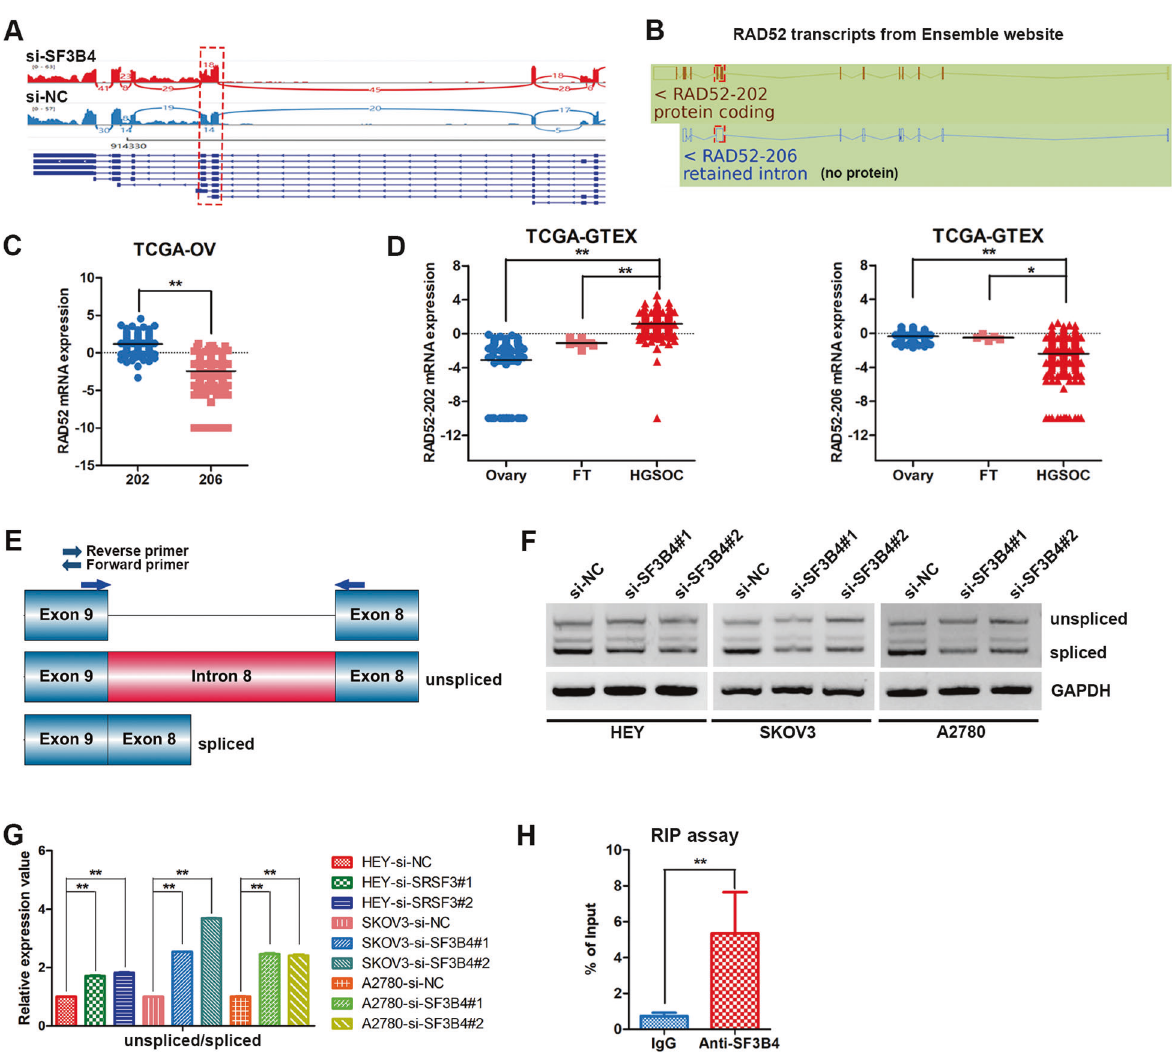
Fig. 5 SF3B4 facilitates ef fi cient splicing of RAD52. A Sashimi plot visualization of RNA-seq reads mapping to RAD52 in HEY cells in response to SF3B4 knockdown. B Schematic diagram showing two splicing variants of the RAD52 mRNA transcript identi fi ed from the Ensemble genome browser. C , D Relative mRNA expression of RAD52 splicing variants described in ( B ) from TCGA ovarian cancer database (202: n = 426; 206: n = 426; HGSOC: n = 426; Ovary: n = 88; FT: n = 5). E Schematic diagram showing the position of intron retention and primers that used for RT-PCR ( n = 3 biologically independent samples). F, G Relative mRNA expression of RAD52 transcripts in ovarian cancer cells after SF3B4 knockdown ( n = 3 biologically independent samples). H The interaction between SF3B4 and RAD52 mRNA was validated by RIP-PCR in HEY cells ( n = 3 biologically independent samples). P -value was obtained by Unpaired t -test. * P < 0.05, ** P <